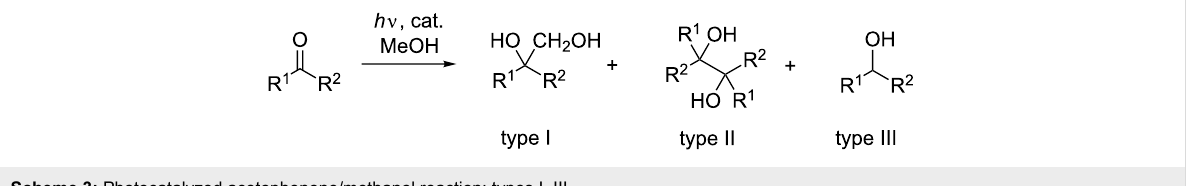
Scheme 3: Photocatalyzed acetophenone/methanol reaction: types